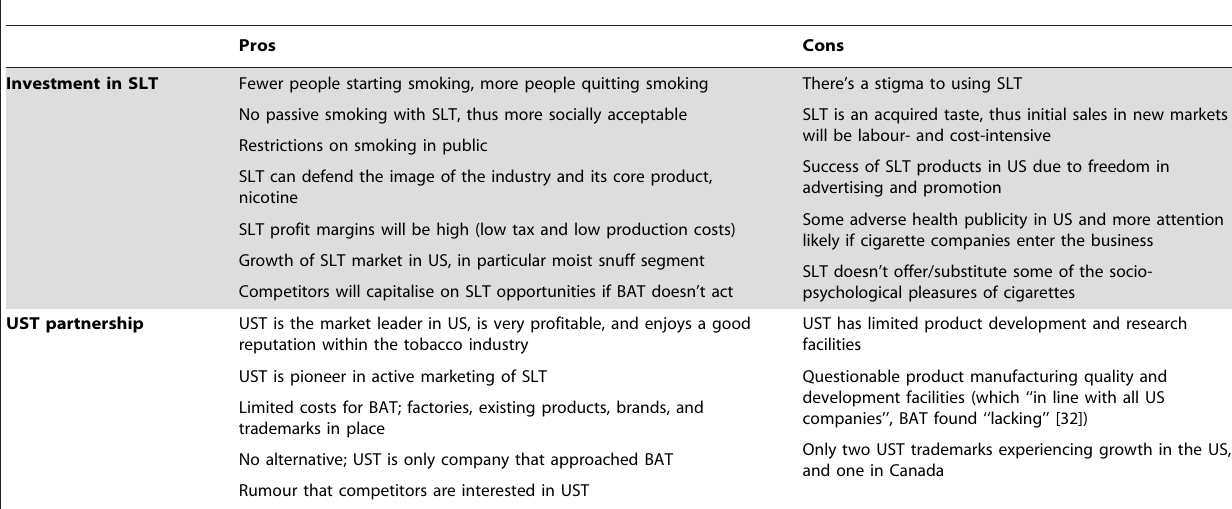
Table 1. Themes of BAT’s rationales for and against investing in SLT, and partnering with UST, based on 1980s BAT documents.